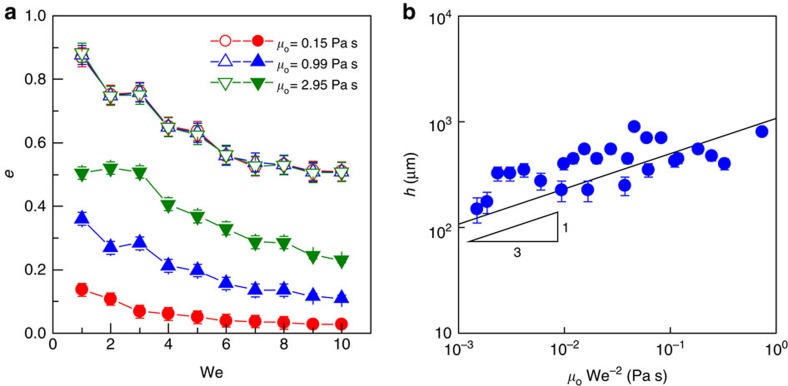
Energy analysis.(a) The variation of the restitution coefficient e of droplet impact on oil bath (h=10 mm) under different We and μo. It is clear that compared to superhydrophobic-like bouncing, the bouncing on the liquid bath is substrate dependent, with a strong dependence of the restitution coefficient e on the oil viscosity. The small e for the droplet impacting on the liquid bath is due to the large viscous energy dissipation as a result of a pronounced deformation at the liquid/air interfaces. (b) The plot of the critical thickness as a function of We and μo, under which the impinging droplet exhibits superhdyrophobic-like bouncing behaviour and follows the power law scaling of hc∼(μoWe−2)1/3. The error bars for restitution coefficient and critical thickness were obtained from the standard deviation of 10 sets of image data calculation.